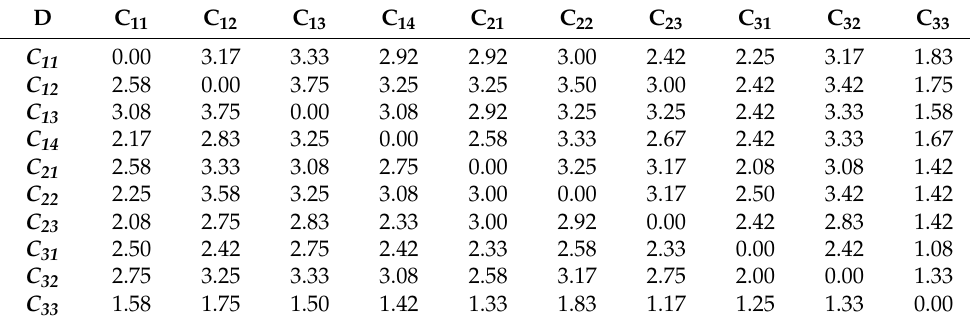
Table 2. Initial influence matrix D .